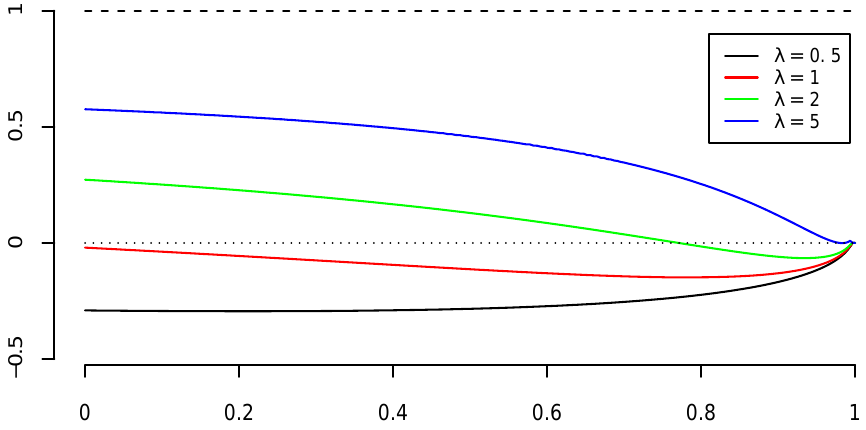
Figure 8. Numerical solution of the integral Equation (20) for different values of λ . The dotted line represents the pinning point ( A = 0) while the dashed line indicates the strike price ( S =